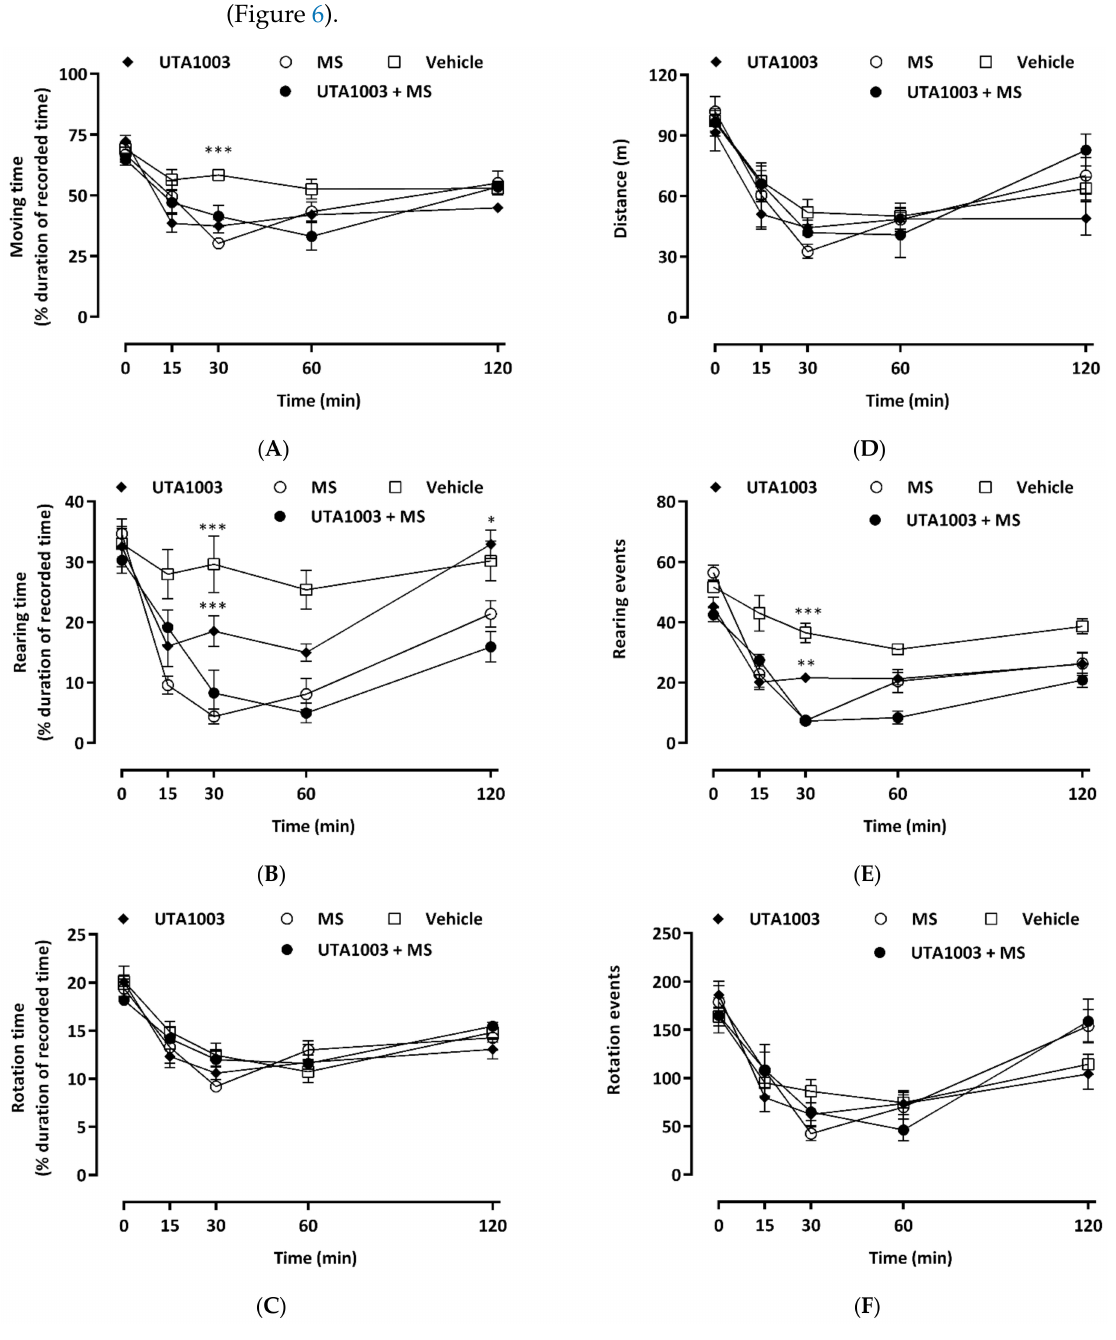
Figure 6. Acute time-dependent effects of morphine and UTA1003 on motor behaviour. Open-field locomotor activities after acute subcutaneous injections of UTA1003 (24.6 mg/kg), morphine (MS, 3.0 mg/kg), their combination, or vehicle were measured in Sprague Dawley rats. The behaviour of treated animals was measured as moving time ( A ), rearing time ( B ), rotation time ( C ), distance travelled ( D ), rearing numbers ( E ), or rotation numbers ( F ) over a period of 120 min. Statistical significance against morphine is shown as * p < 0.05, ** p < 0.01 and *** p < 0.001 at the same time point and was calculated using one-way ANOVA with Bonferroni’s multiple comparisons. Values are presented as mean ± SEM (n = 6 animals per